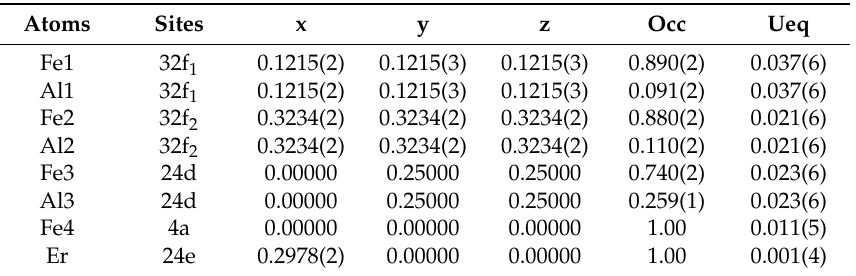
Table 2. Atomic coordinates, occupations, and equivalent isotropic displacement parameters for Er 6 Fe 20 Al 3 .